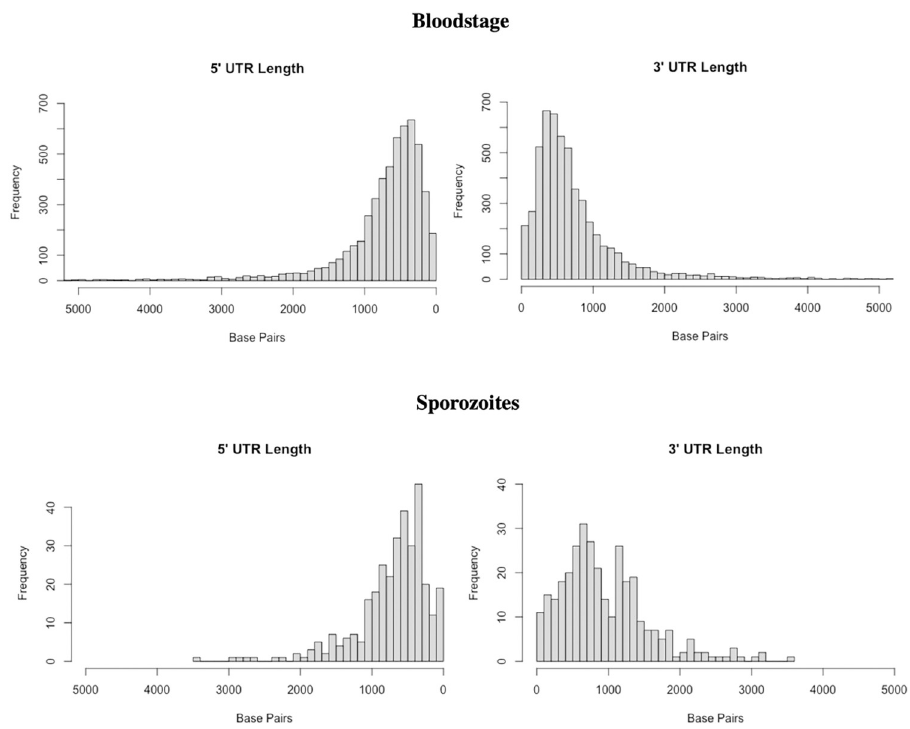
Fig 3. UTR length distributions. Distribution of UTR lengths (x-axis, in bp) for transcripts expressed by blood-stage parasites (top) and sporozoites (bottom).